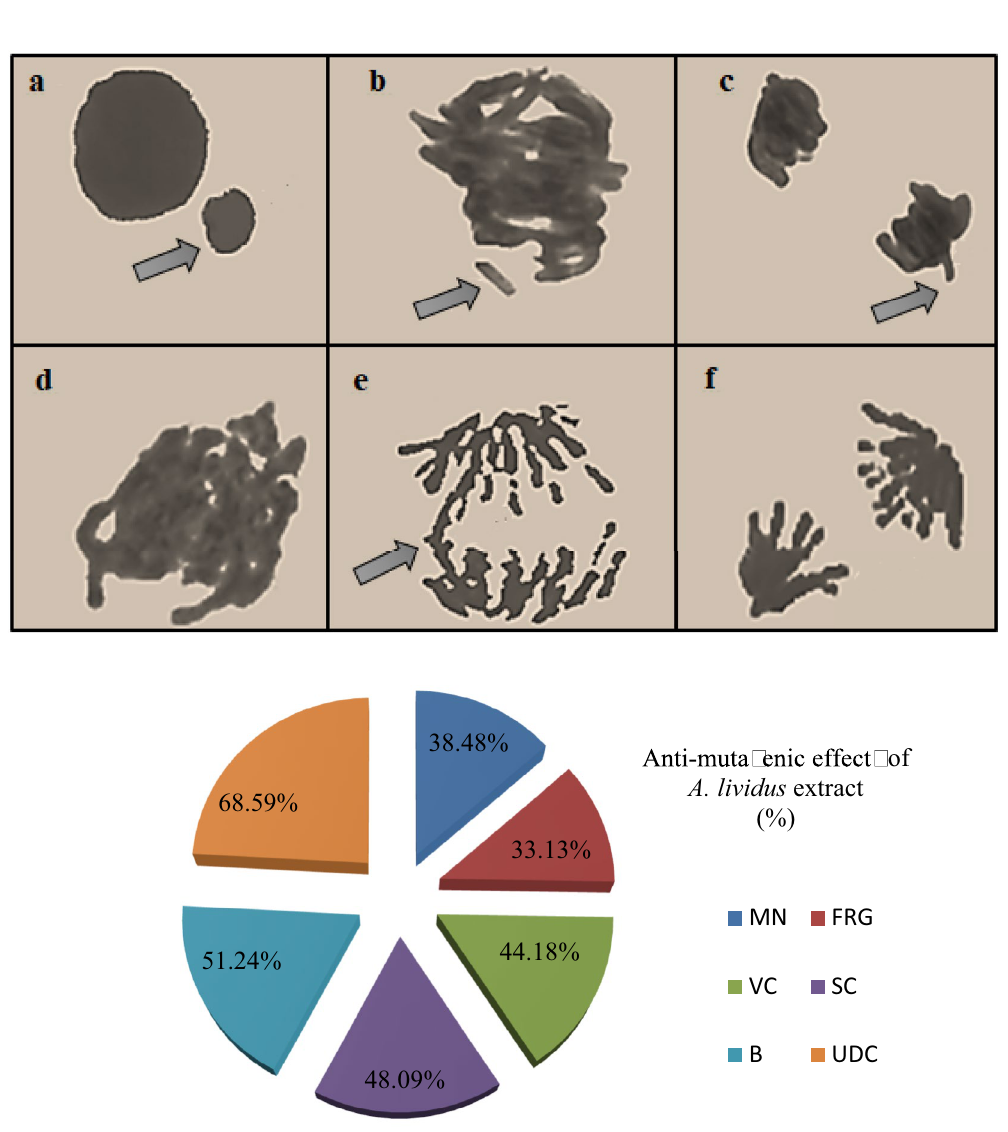
Figure 7. Genotoxicity induced by NaN 3 and anti-mutagenic effects of A. lividus extract. ( a ) MN, ( b ) fragment, (c) vagrant chromosome, ( d ) sticky chromosome, ( e ) bridge, ( f ) unequal distribution of